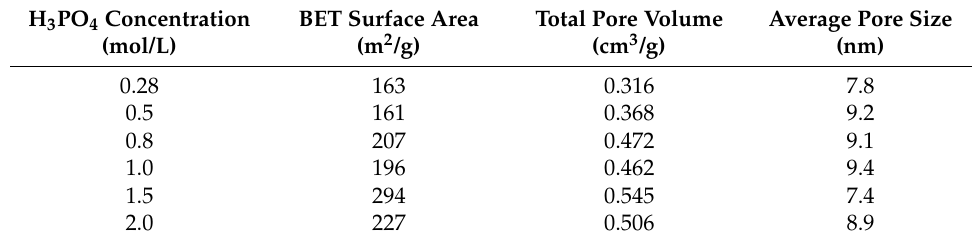
Table 2. Pore parameters of mesoporous TiO 2 at different H 3 PO 4 concentrations. Reprinted with permission from reference [26]. Copyright 2018, Elsevier.